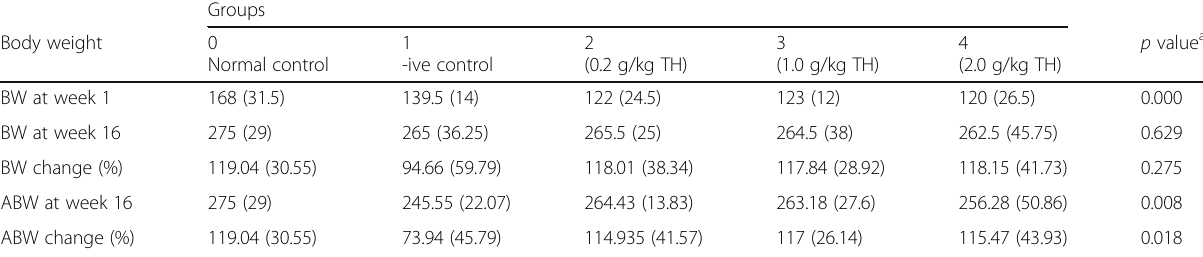
Table 2 Body weight measurements of rats at week 1 and week 16 Groups